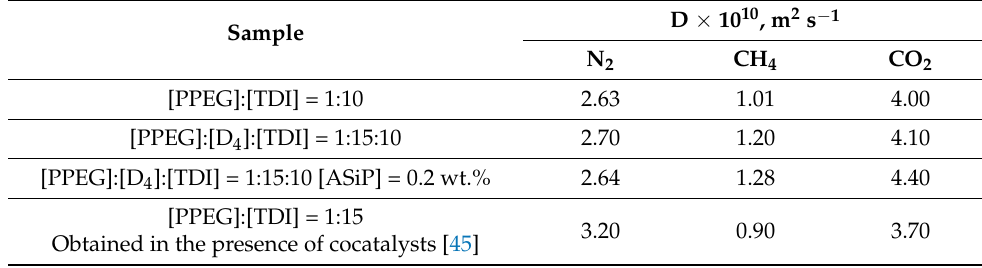
Table 4. Diffusion